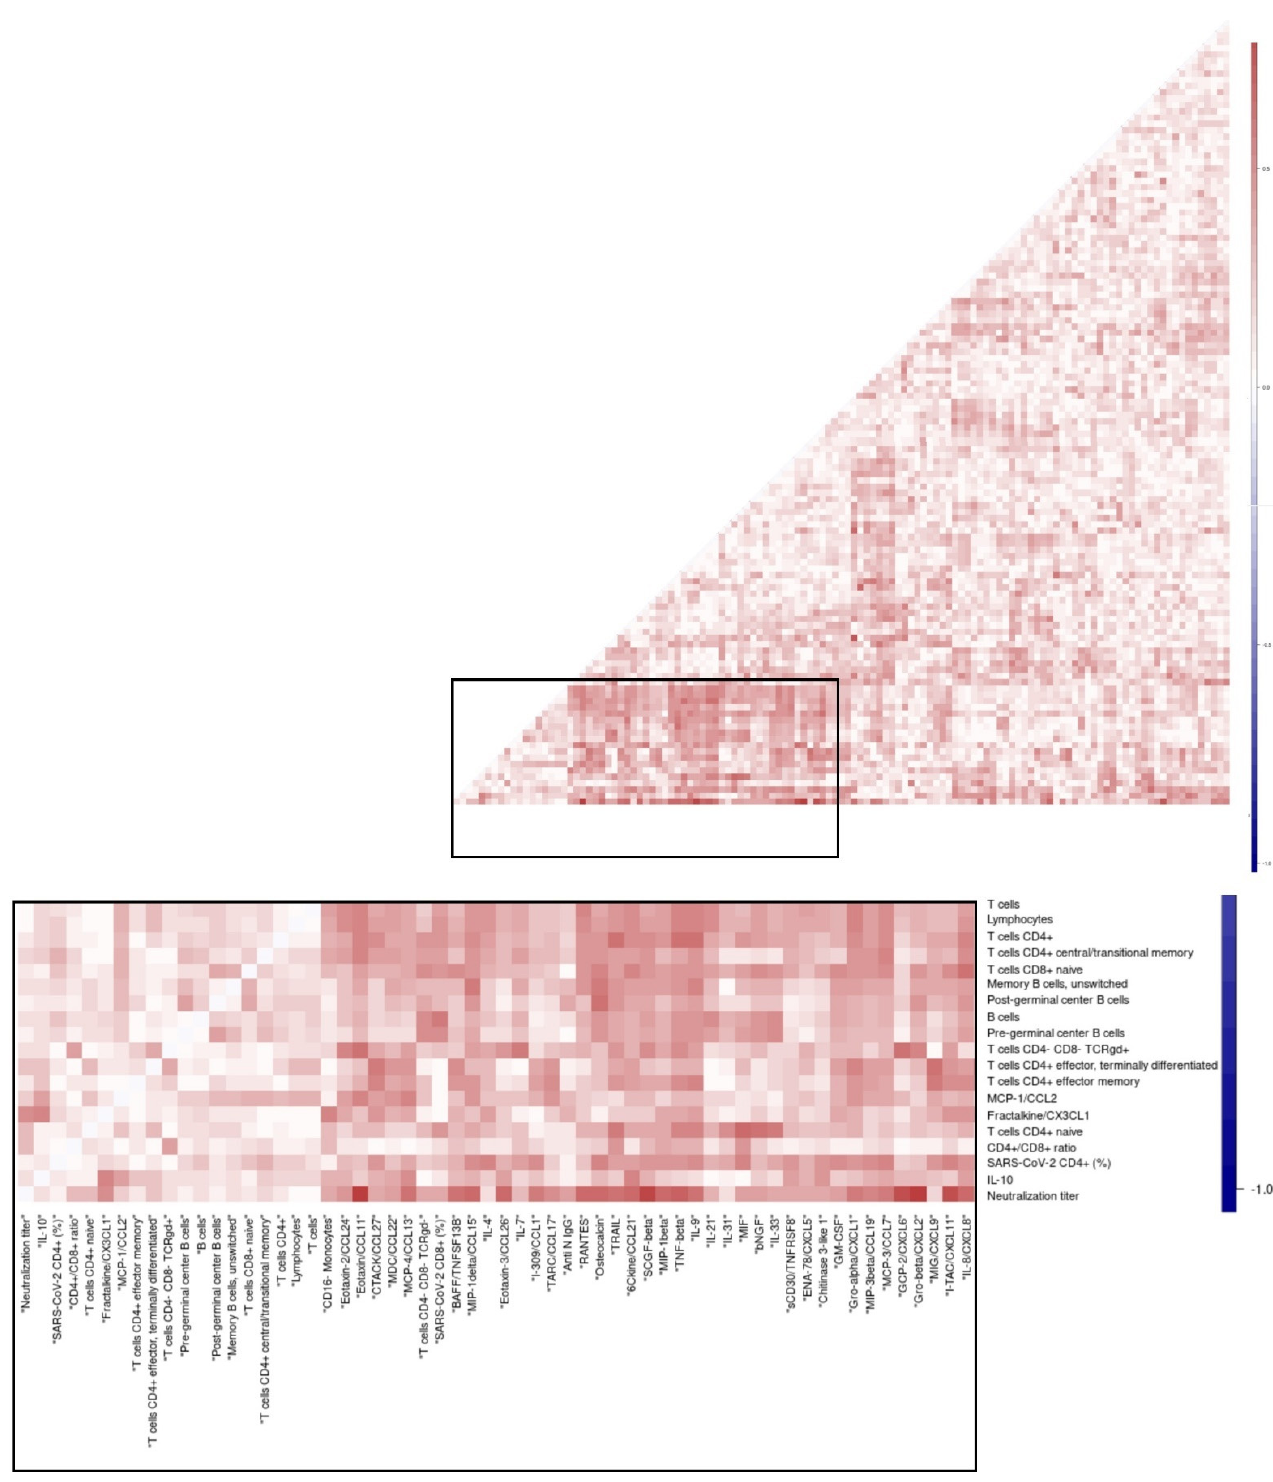
Figure 8. CD4+ T cell subset counts inversely correlate with proinflammatory cytokines: naïve CD4 T cells with MIF, and CD4+ T cells with IL-9/TNFbeta, in patients with rapid viral clearance. Correlation heatmaps of the maximum level of immune parameters in individual patients, for the differences between the patient groups with viral clearance > 21 days and clearance ≤ 21 days. MIF; macrophage migration inhibitory factor. Pearson’s correlation coefficient.